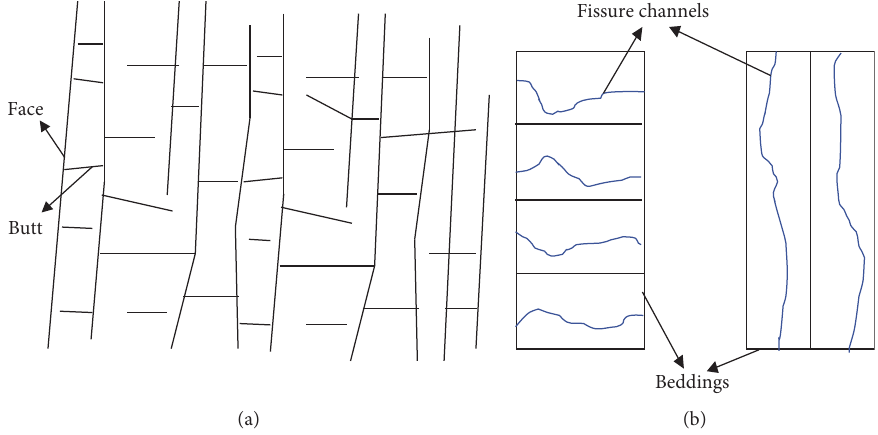
Figure 6: Schematic diagram of fracture distribution. (a) Cleat-trace patterns in plan view. (b) Distribution of fissure